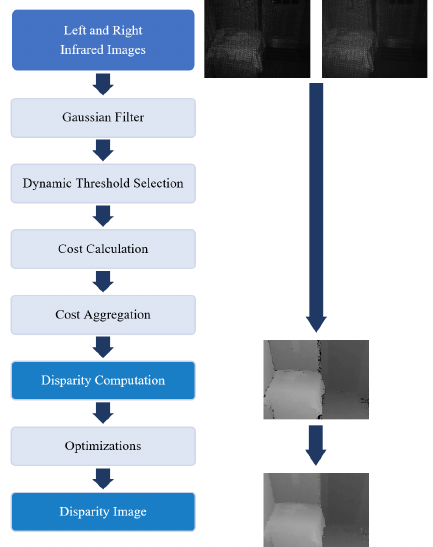
Figure 1 . A flow chart of our